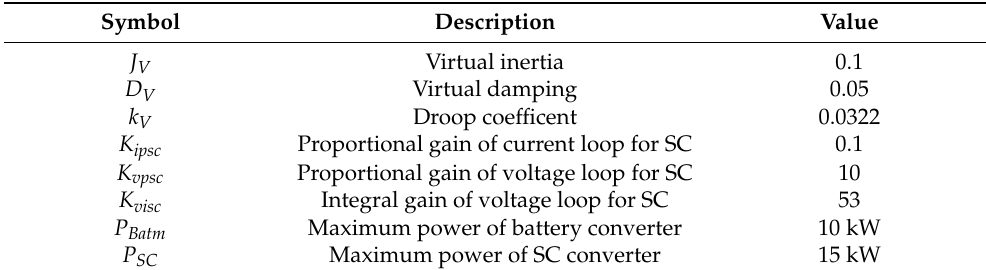
Table 2. Main parameters of the system for Cases B and